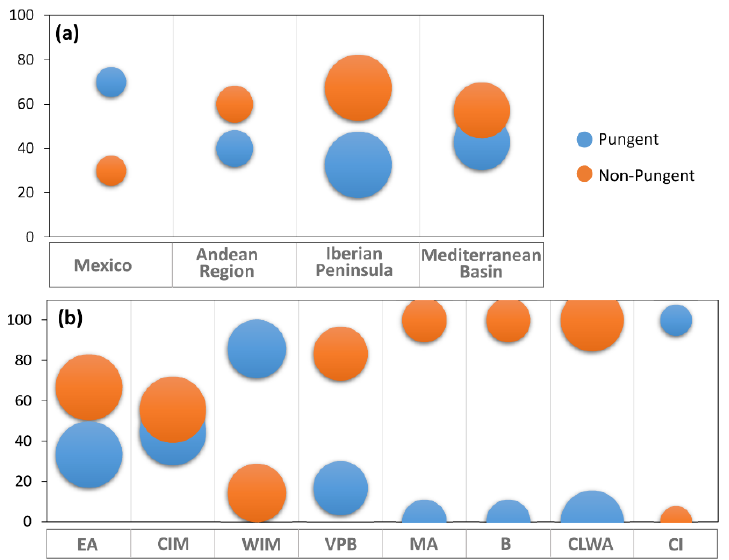
Figure 4. Percentage of pungent and non-pungent accessions from the different global ( a ) or Iberian ( b ) geographical regions. The size of the circles is proportional to the number of accessions within each geographical group. EA = European Atlantic, BP = Betica Province, CIM = Central Iberian Mediterranean, CLWA = Coastal Lusitania and West Andalusia, MA = Murcia and Almeria, VPB = Valencia-Provence and Balearic, WIM = West Iberian Mediterranean, CI = Canary Islands.